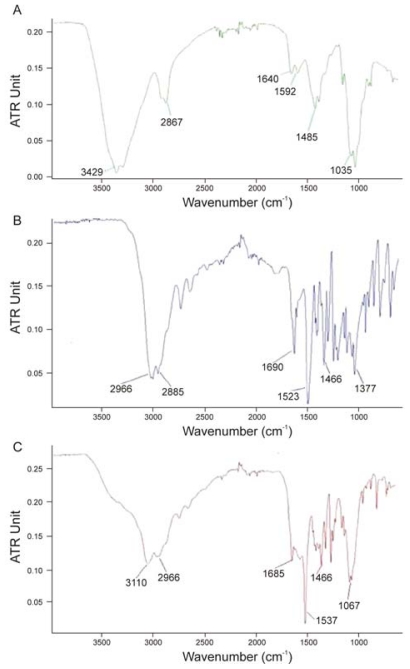
FTIR spectra of (A) chitosan (C), (B) l-glutamic acid (l-GA), and(C) chitosan- l-glutamic acid derivative (Cl-GA). Reprinted from Carbohydrate Polymers 76, 2009, Singh, J., Dutta, P.K., Dutta, J., Hunt, A.J., Macquarrie, D.J., Clark, J.H., Preparation and properties of highly soluble chitosan-l-glutamic acid aerogel derivative, 188–195, Copyright (2010), with permission from Elsevier [144].